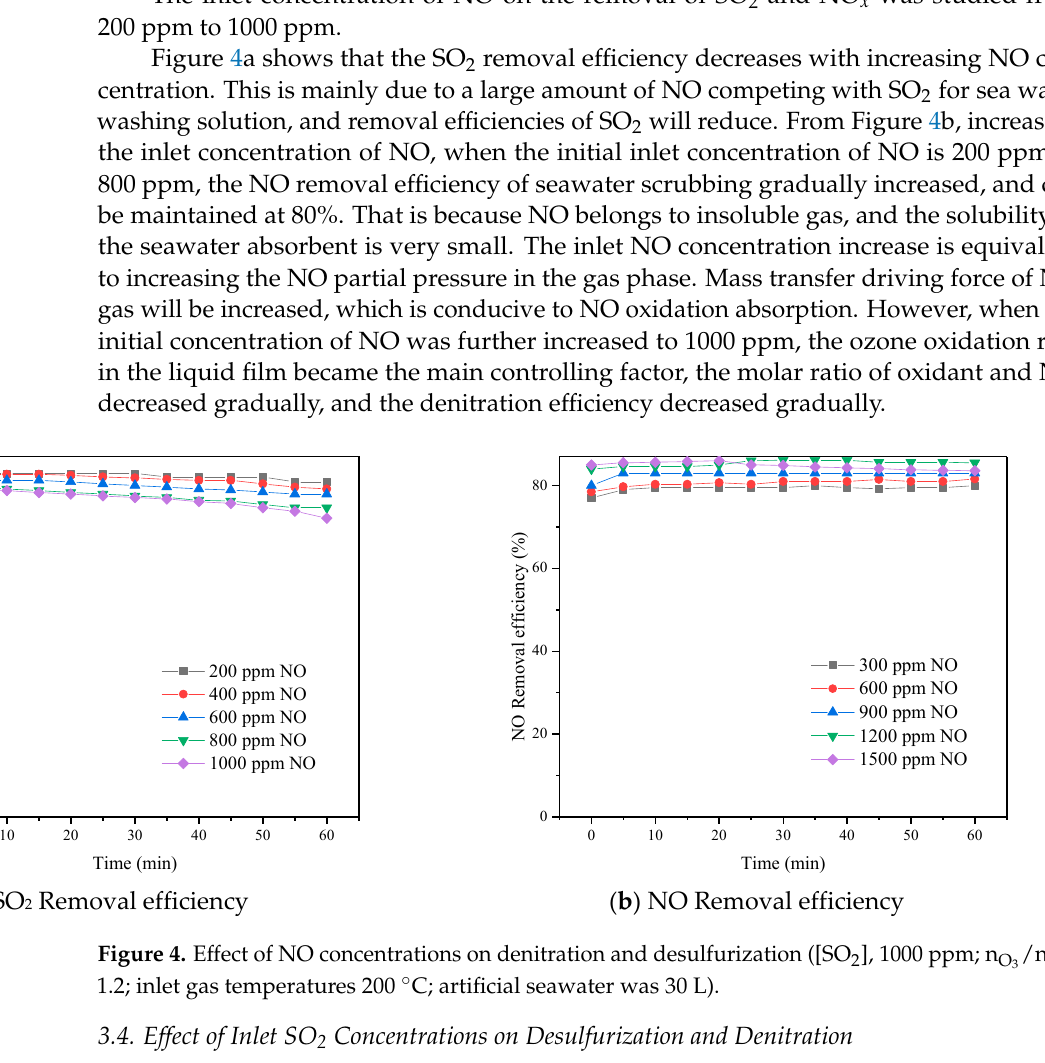
Figure 3. Effect of seawater scrubbing temperature (Initial temperatures of the scrubbing solution were 23 °C. Washing liquid flow rate was about 1 L·min − 1 ).